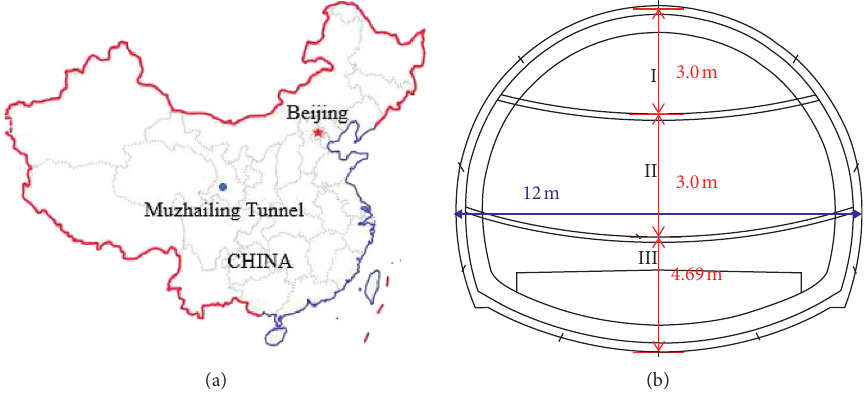
Figure 1: (a) The location of the Muzhailing tunnel, Gansu, China. (b) Tunnel structure